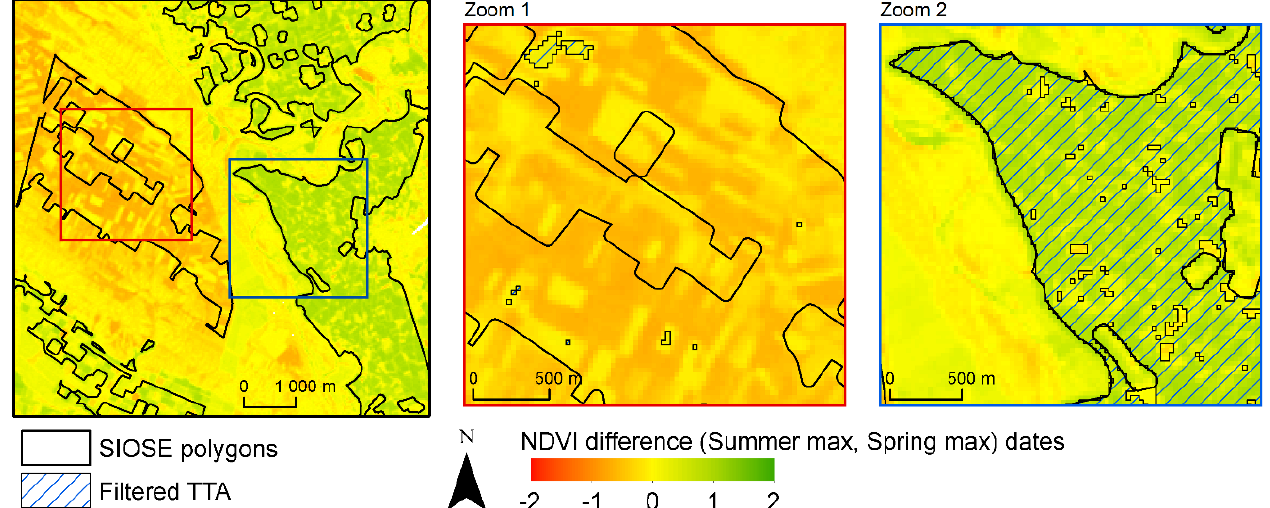
Figure 14. Rule 4 applied to irrigated herbaceous crop polygons. Brown NDVI depict negative NDVI temporal gradients; yellow is related to low contrasting patterns (fallows); green depicts positive NDVI temporal gradients. Positive and negative gradient domains are detailed in zooms 1 and 2.